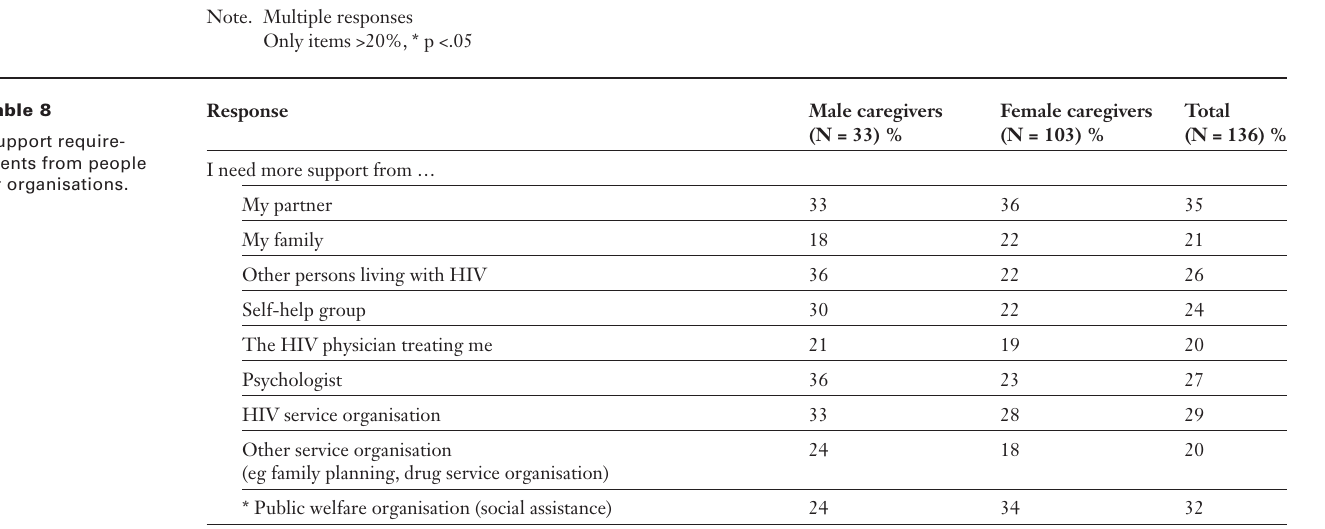
Caregiver’s support needs.